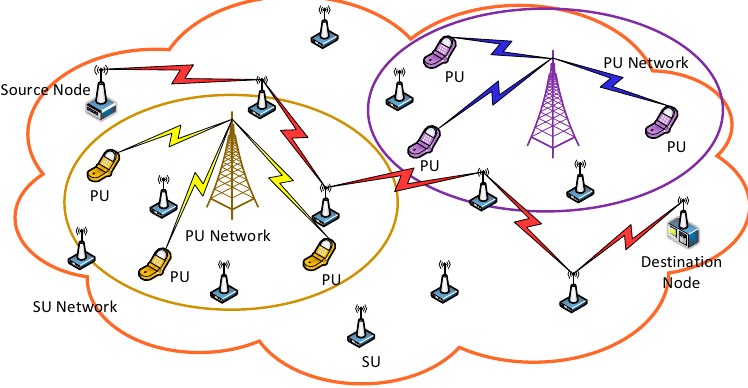
Figure 1. Multi-hop cognitive networking scenarios.